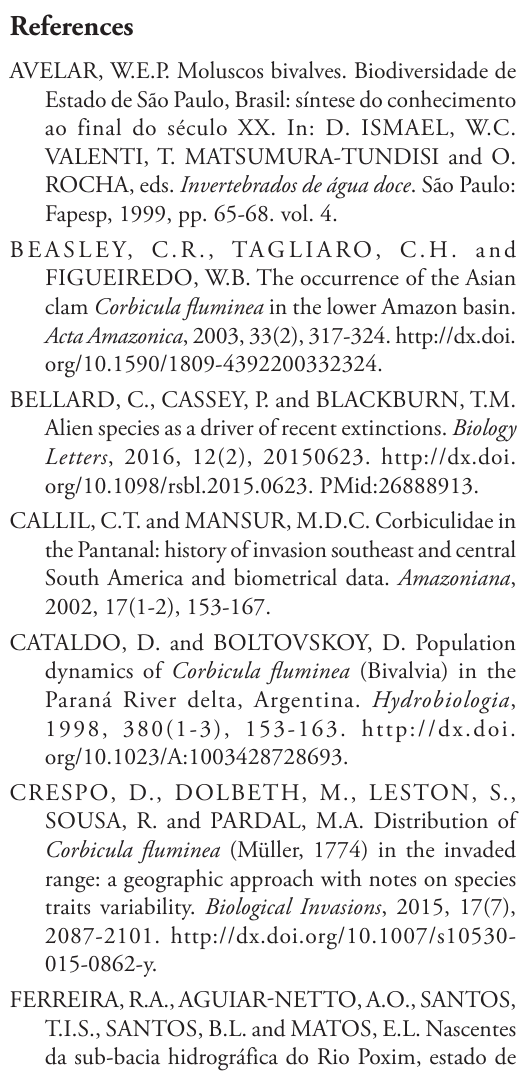
FIGUEIREDO, W.B. The occurrence of the Asian clam Corbicula fluminea in the lower Amazon basin.